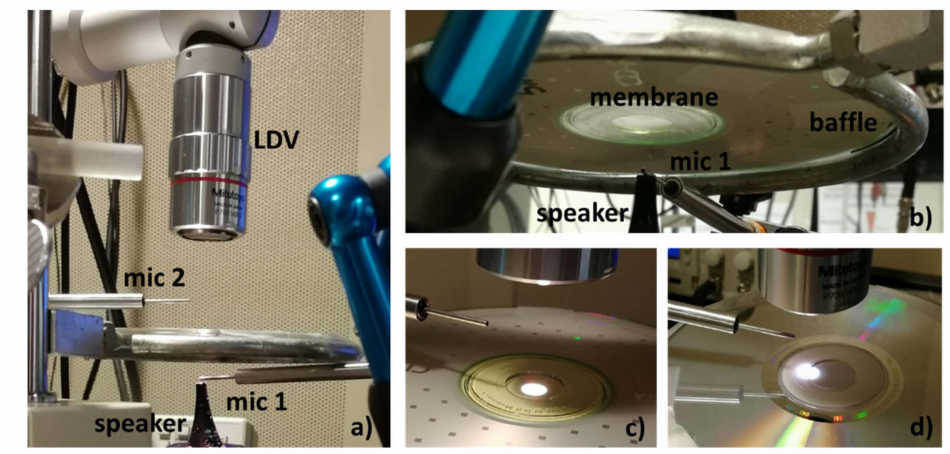
Figure 9. Disposition of the different elements in the experiment ( a , b ). Measurement at the center of the membrane ( c ). Measurement at a support point ( d